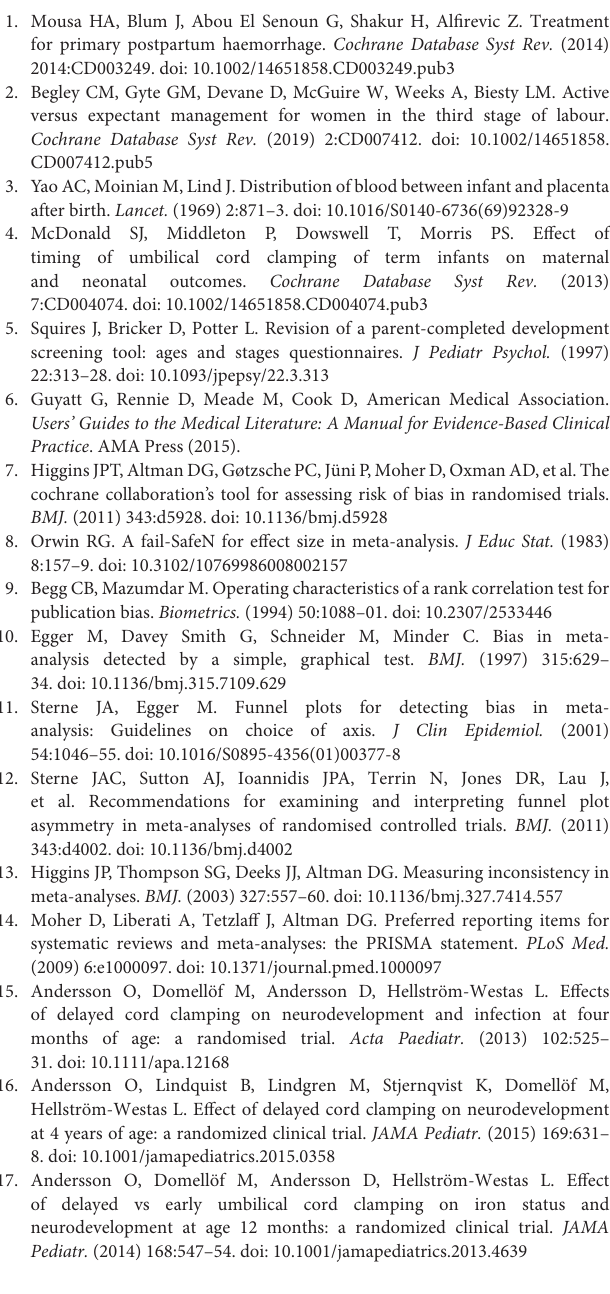
Supplementary Table 3 | Characteristics of the included trials. ( ∗ ) This trial (NCT01581489) was a follow up of the same cohort of NCT01245296. Supplementary Material 1 | Included and excluded